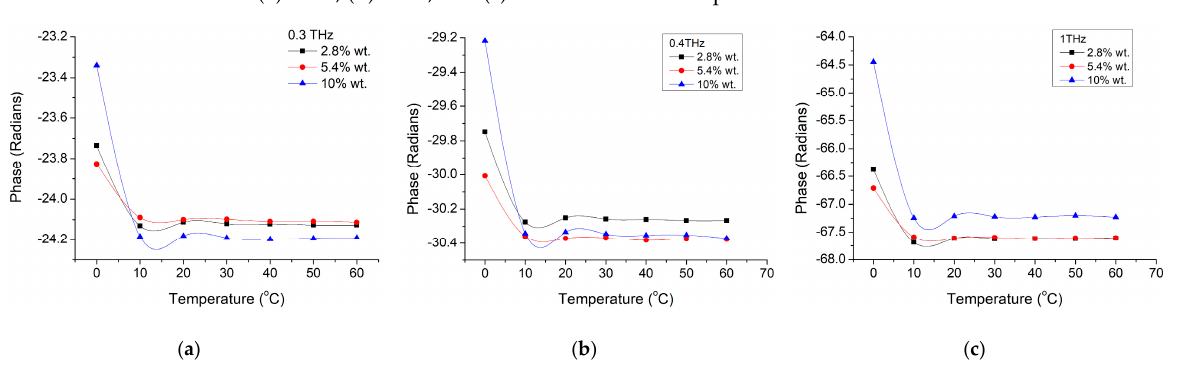
Figure 12. BTO-epoxy phase variation with frequency for different nanoparticle concentrations of ( a ) 2.8%, ( b ) 5.4%, and ( c ) 10% at different temperatures.